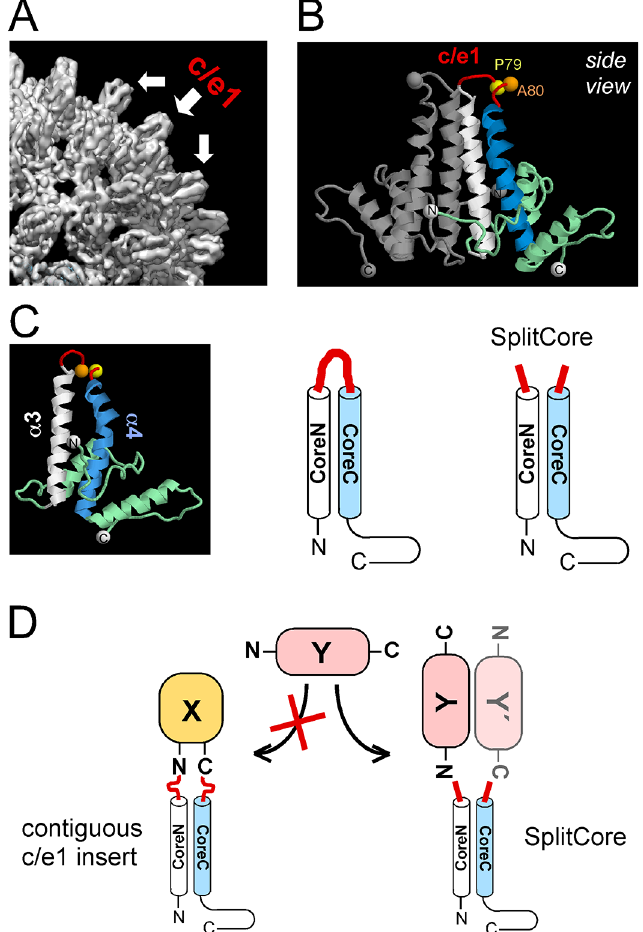
Fig 2. Structural features of HBc CLPs. (A) The spikes on HBc CLPs comprise the immunodominant c/ e1 epitope. The picture shows a section from a cryo EM derived 3D reconstruction of a 120 dimer (triangulation number T = 4) HBc CLP (B. Böttcher and MN, unpublished data). (B) X-ray derived structure of a HBc149 dimer. The structure is based on pdb accession number 1QGT. Two core protein subunits associate into a symmetric dimer. One subunit is shown in grey, in the other the ascending central helix a3, the descending helix a4 and the connecting loop comprising the c/e1 epitope are colored white, blue and red. ( C) Correlation between the 3D structure of a HBc monomer and schematic representations of contiguous chain HBc versus SplitCore HBc. (D) HBc as carrier for heterologous proteins. A foreign protein X with compatible 3D structure may be fused into c/e1 via both termini. A foreign protein Y with far apart termini may interfere with folding and CLP formation when fused over both ends but be compatible when fused over one end only in the SplitCore system. Fusions can be made to the coreN or the coreC segment, or